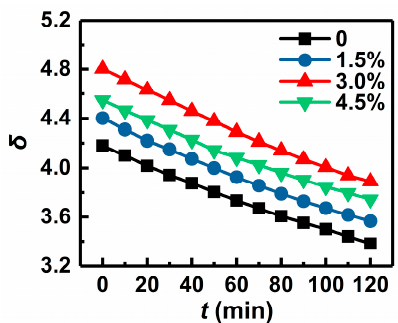
Figure 2. δ – t curves of an undoped MgO film sample and three Au-doped MgO film samples with doping concentrations of 1.5%, 3.0%, and 4.5%.